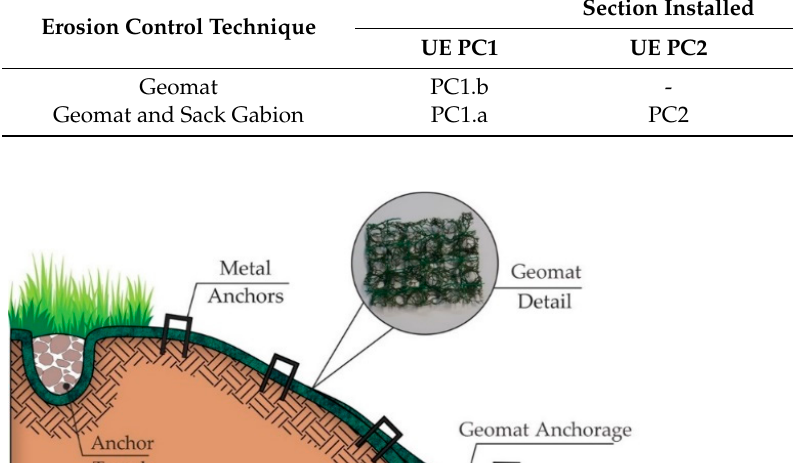
Table 2. Erosion control techniques evaluated and respective installation sites. Figure 3. Identification of the sections installed in the HPP experimental units: ( a ) UE1 Porto Colômbia, ( b ) UE Volta Grande, and ( c ) UE2 Porto Colômbia.